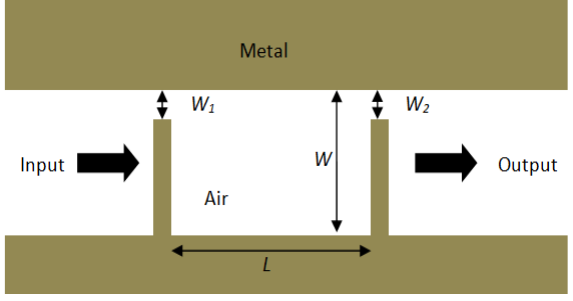
Fig.2. Schematic of the tunable plasmonic filter Thus, the resonance condition depends on the length of the resonator L and the effective index n